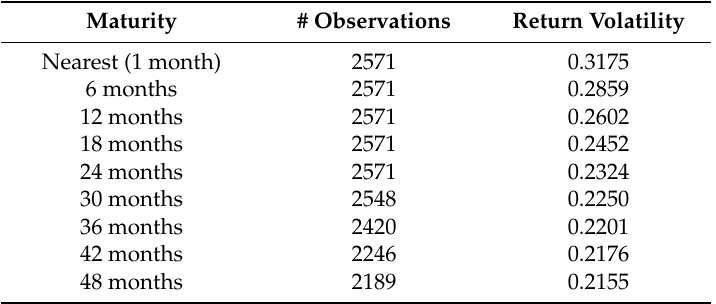
Table 1. Volatility of some futures contracts according to their